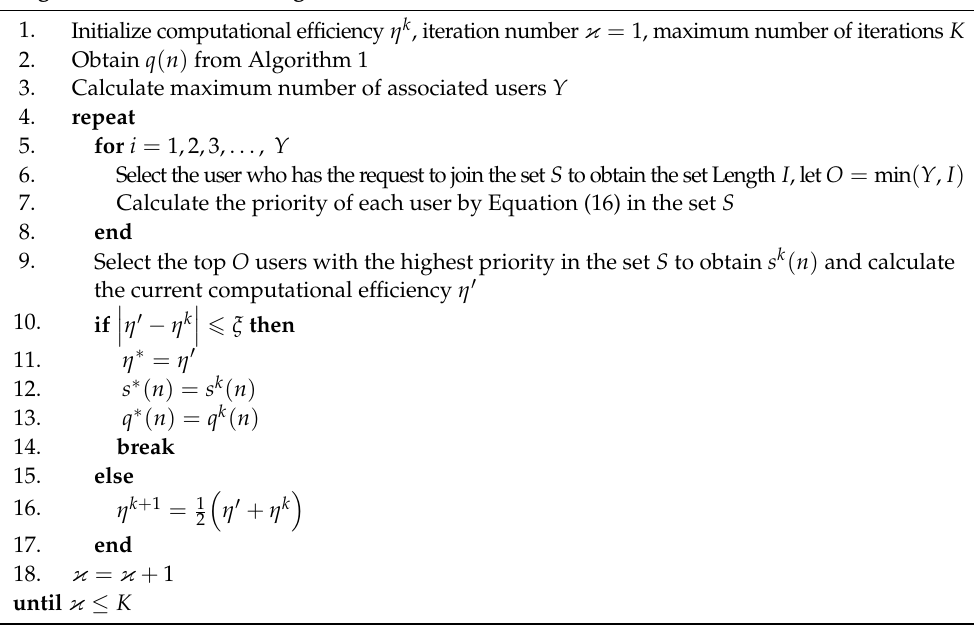
Algorithm 2. Association